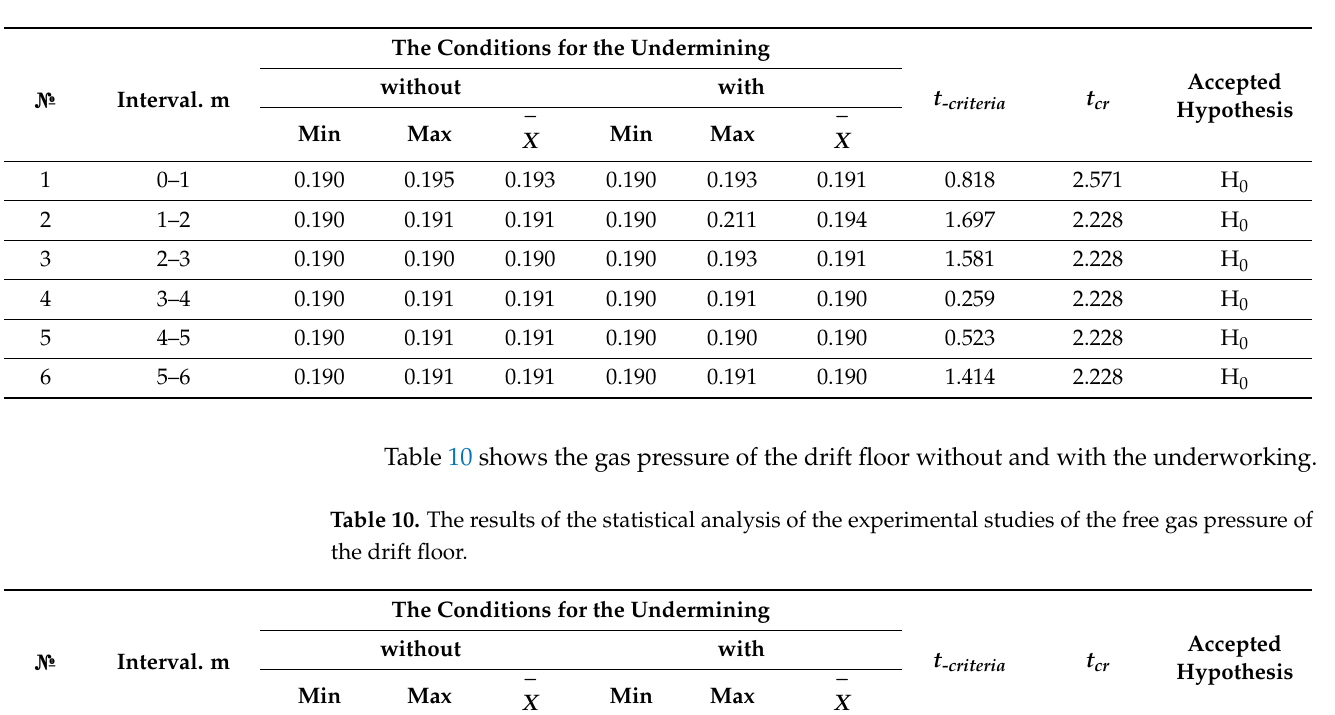
Table 9. The results of the statistical analysis of the experimental studies of the free gas pressure of the drift roof.